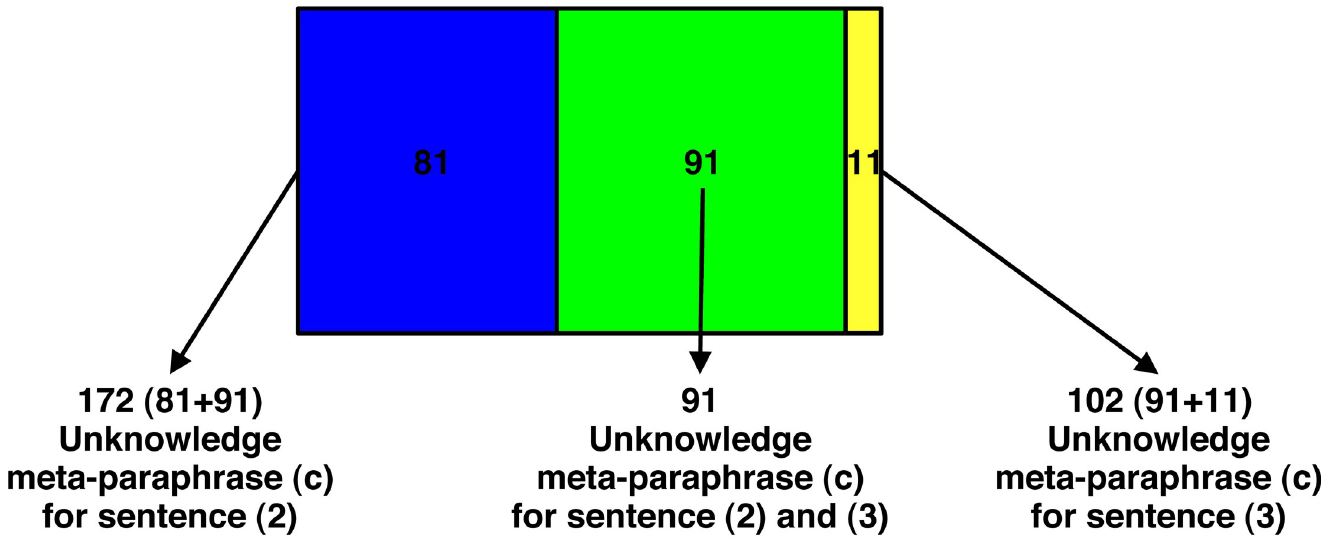
Fig 9. Participants who selected the unknowledge EMP for sentences (2) and (3). � The green section of the figure (i.e., the overlapping area) refers to subjects who assigned EMP (c) to both sentence (2) and sentence (3); the blue section of the figure refers to subjects who assigned EMP (c) to sentence (2), but not to sentence (3); the yellow section refers to subjects who assigned EMP (c) to sentence (3), but not to sentence (2).